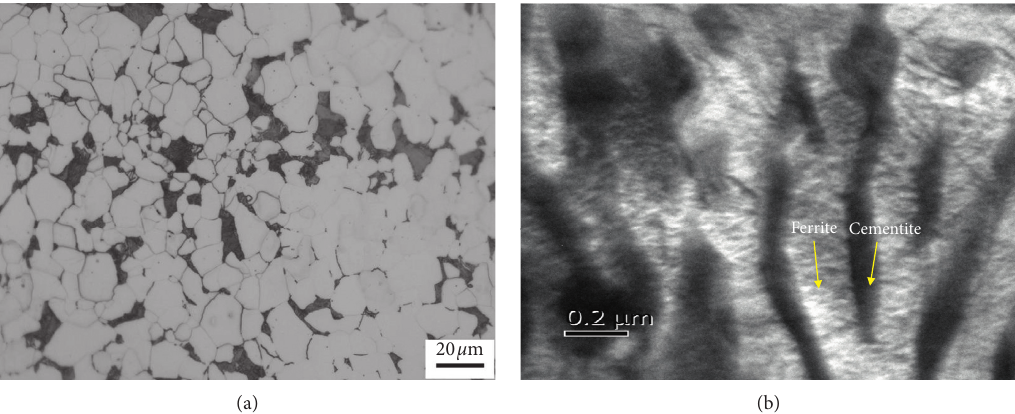
Figure 4: Metallographic and microstructure morphology of grade-A ship steel. (a) Optical metallography. (b) TEM image.